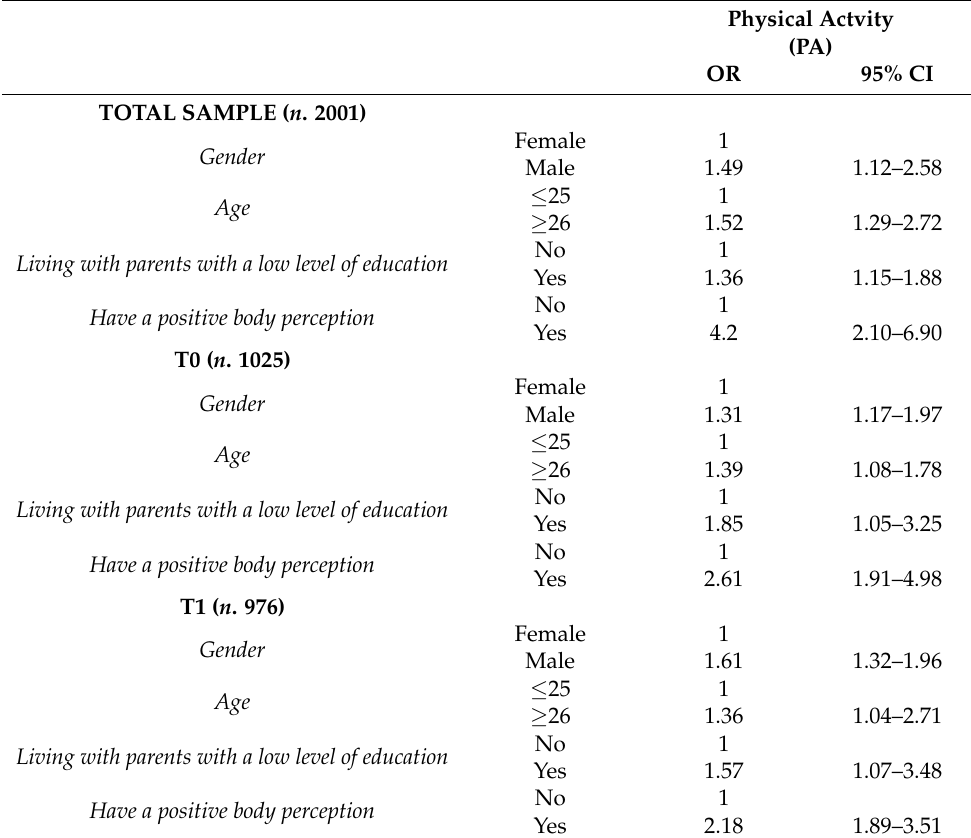
Physical Actvity (PA) OR 95% CI